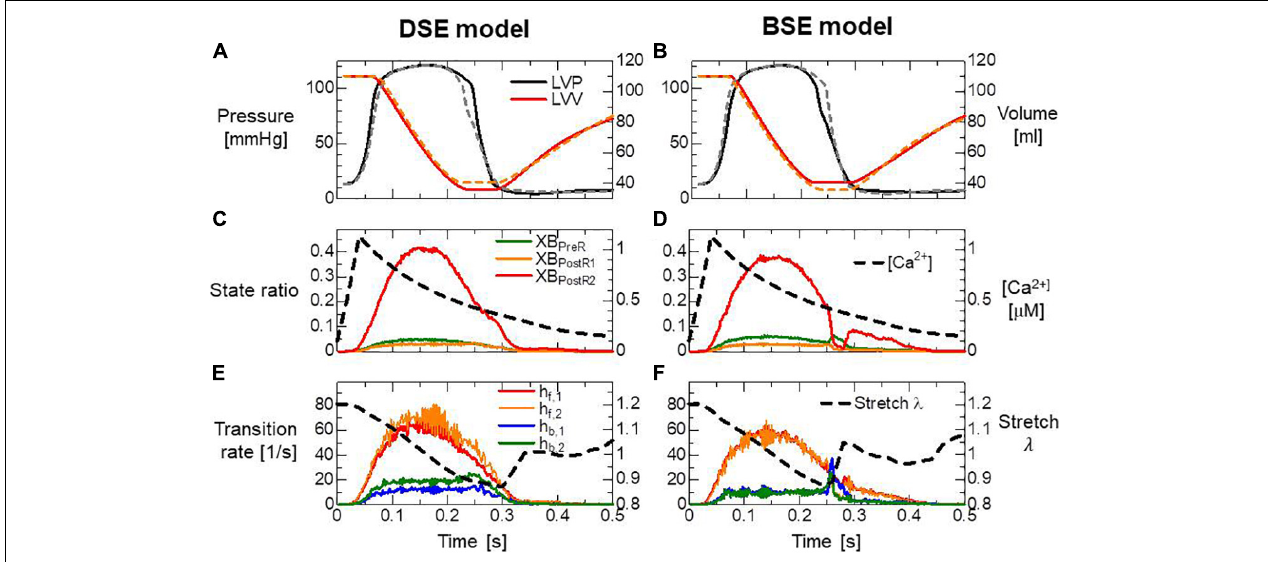
FIGURE 12 | (A,B) Time transients of the left ventricular pressure (LVP) and volume (LVV) of the FE ventricle model, (C,D) the ratio of binding states to the Ca 2 + concentration, and (E,F) the transition rates between the binding states and the stretch given by averaging the half-sarcomere models imbedded at the endo lateral left ventricular wall (elements inside a sphere of 3 mm radius). Panels (A,C,E) and panels (B,D,F) are the results of the DSE and BSE models, respectively. In panels (A,B) , the broken lines indicate the results of counterparts. The transition rates in panels (E,F) were calculated by dividing the total number of transitions per unit time by the total number of myosin molecules.